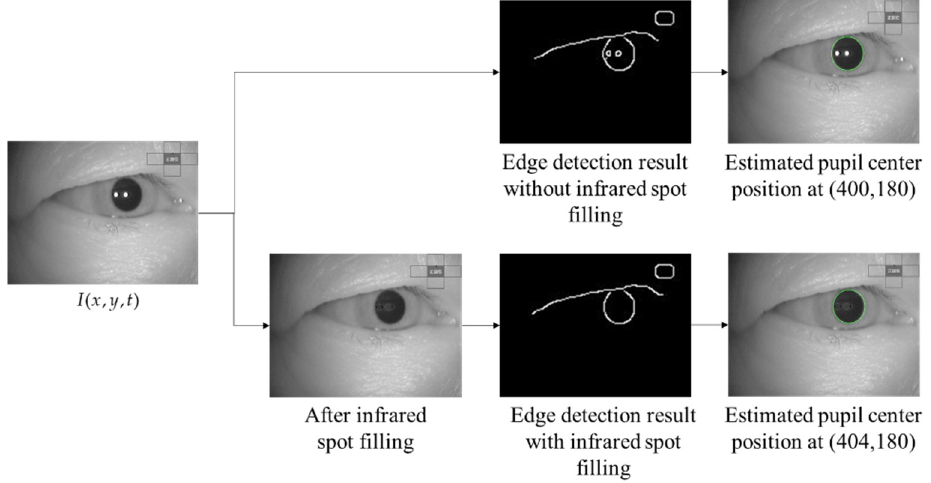
Figure 6. Sample of infrared spot filling to the detection result.